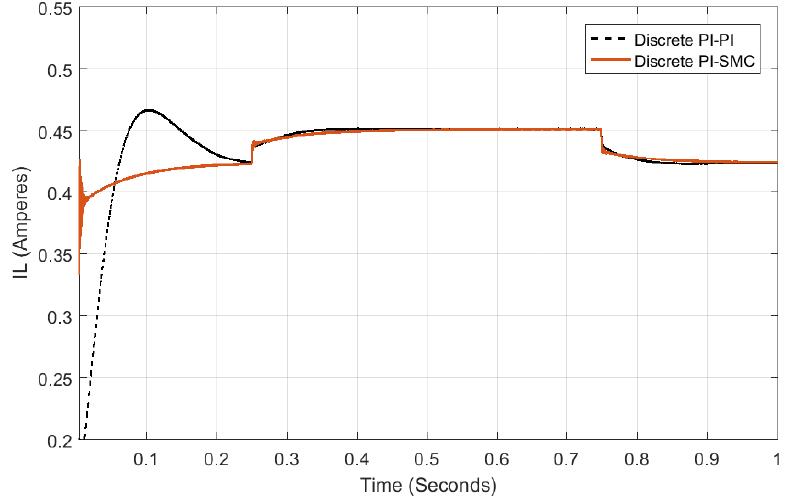
Figure 14. Simulation of the input current i L of the converter in the case of 6% load